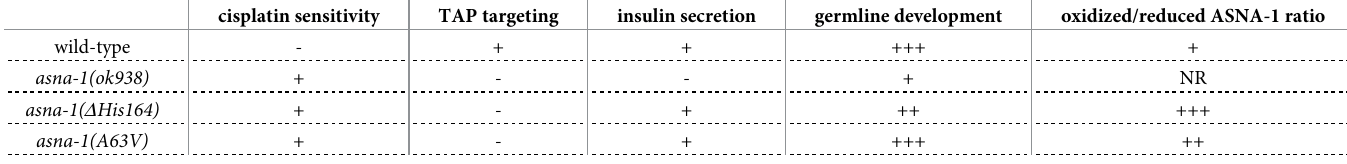
Table 1. Summary of phenotypes of asna-1 deletion and point mutants discussed in the paper to highlight the different phenotypes displayed with differing levels of ASNA-1 activity. Cisplatin sensitivity is independent of germline development ability and insulin secretion ability but linked to the TAP targeting phenotype. Animals with a large increase in the ratio of oxidized v/s reduced ASNA-1 will still display the cisplatin sensitivity phenotype indicating that increased ASNA-1 levels do not protect these mutants from cisplatin induced